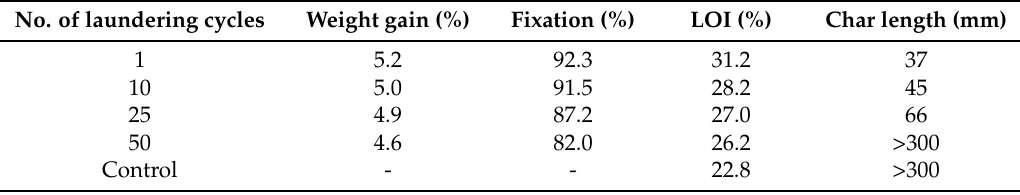
Table 8. The weight gain, fixation, LOI and vertical burning flammability of the Nomex ® /cotton blend fabric treated with 8% HFPO, 3% BTCA and 2% TEA, cured at 170 ◦ C for 3 min and finally subjected to different number of laundering